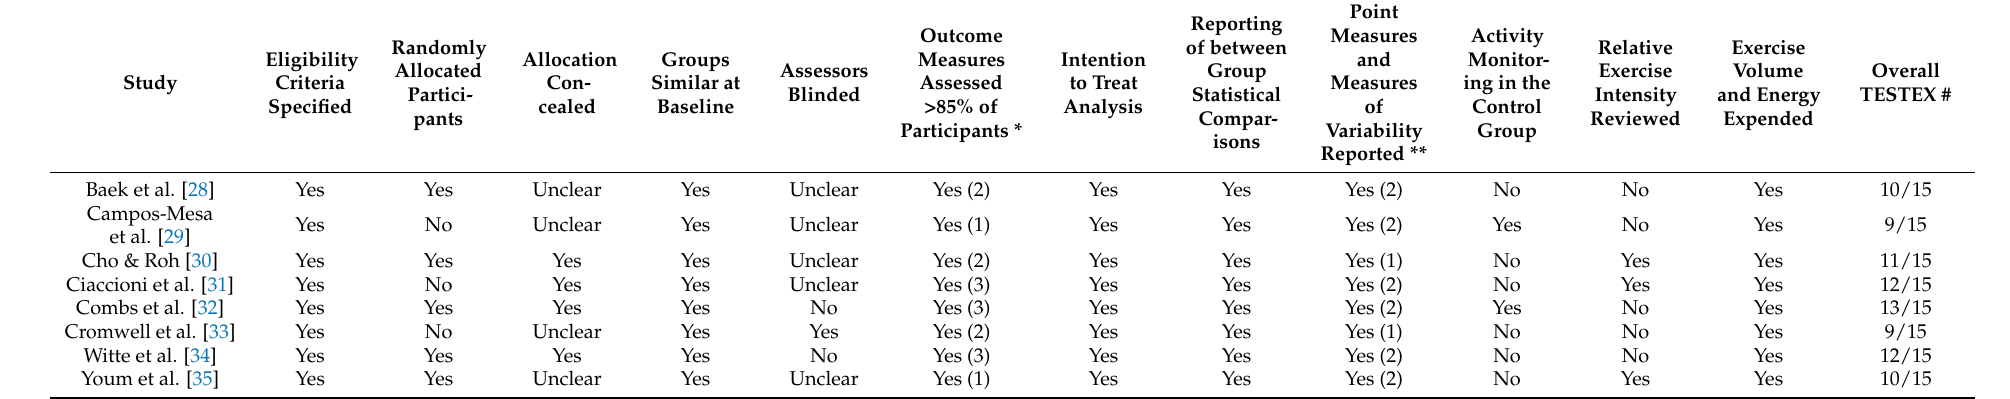
Table 2. Study quality assessment according to TESTEX